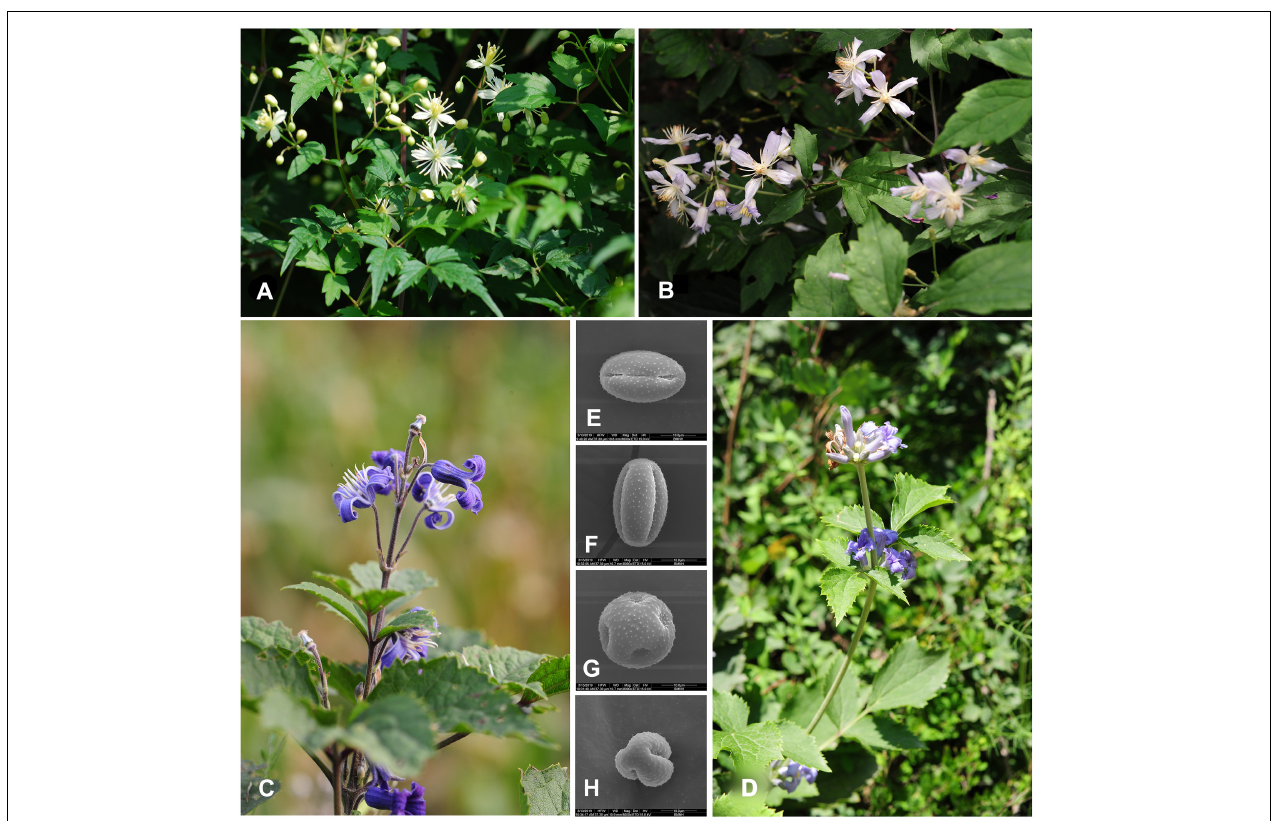
FIGURE 1 | Pictures of Clematis pinnata and its putative parents and their representative pollen grains under an electron microscope. C. brevicaudata (A) and its pollen (F) ; C. pinnata (B) and its pollen (E) ; C. heracleifolia (C) and its pollen (H) ; C. tubulosa (D) and its pollen (G)